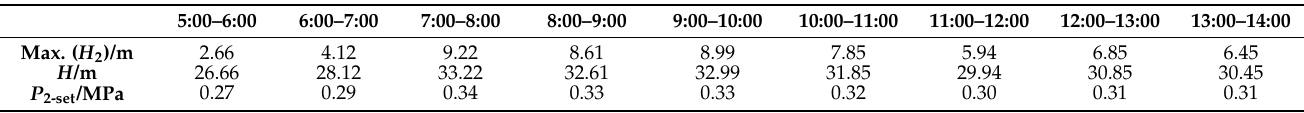
The results of P 2-set are shown in Table 5, with a regulation period of 1 h. Table 5. P 2-set (MPa) during 5:00–14:00.